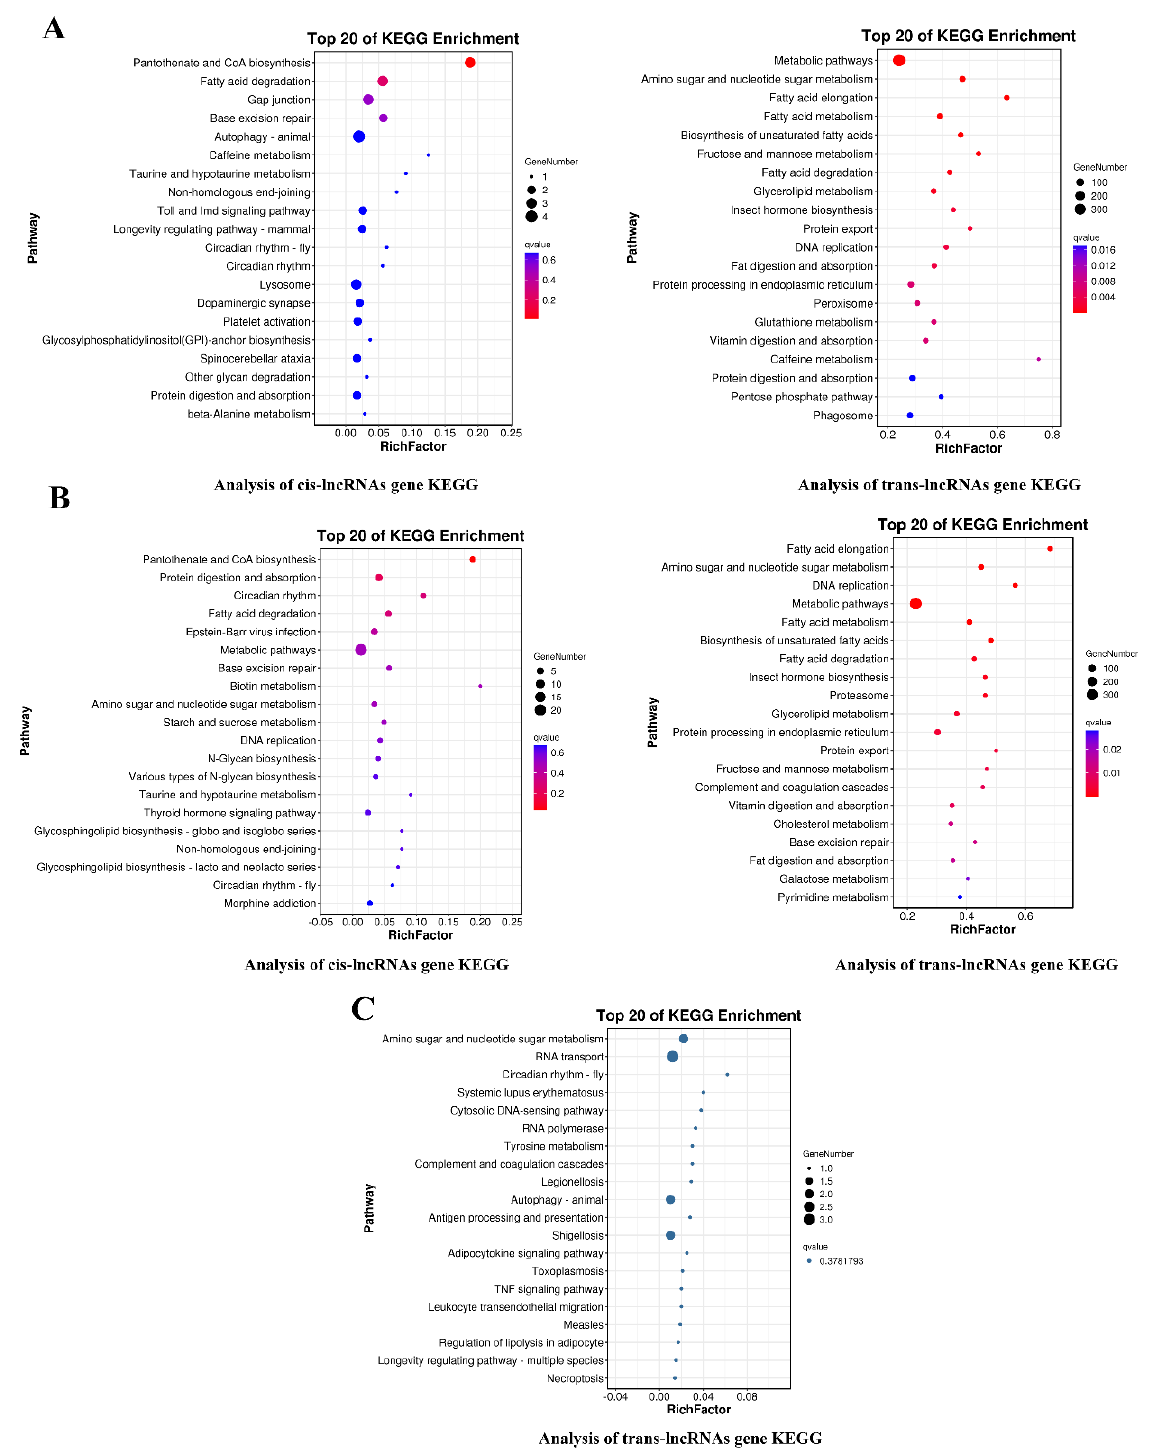
Figure 7. Predicted target genes of the differentially expressed lncRNAs. ( A ) KEGG enrichment analysis of PE vs. DE cis/trans lncRNA target genes. ( B ) KEGG enrichment analysis of PE vs. AE cis/trans lncRNA target genes. ( C ) KEGG enrichment analysis of DE vs. AE trans lncRNA target genes.